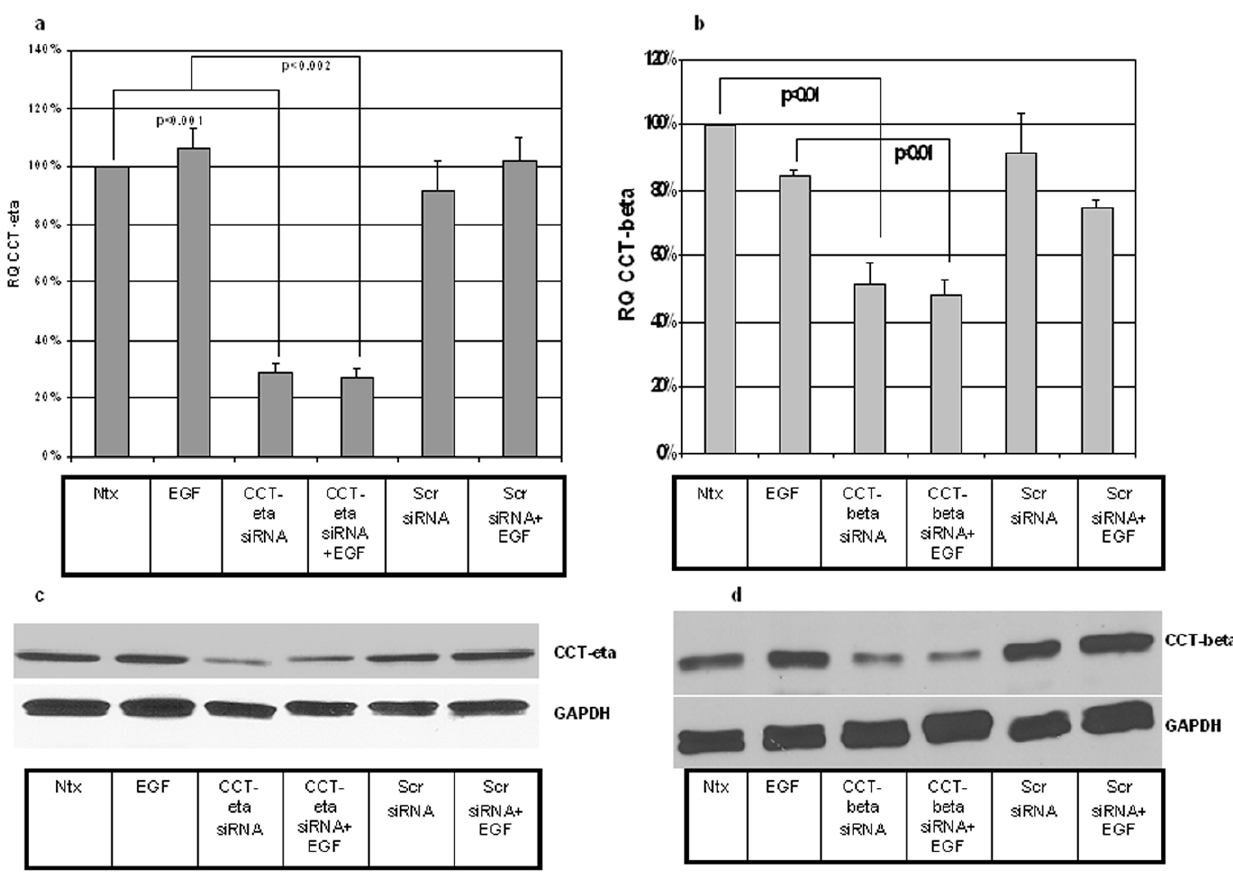
Figure 3. siRNAs against CCT-eta and CCT-beta decrease both basal and EGF- induced mRNA and protein levels of their targets in fibroblasts. (a & b) qRT-PCR analysis of CCT-eta and CCT-beta mRNA levels showed effective inhibition of both basal expression and EGF-induction in siRNA-transfected adult fibroblasts. Results are expressed as relative quotient (RQ) of measured CCT-eta or CCT-beta mRNA and were calculated as a percentage of baseline control levels (100%). Values are means 6 SEM of six independent studies, each performed in duplicate. Statistical analyses were performed with Student’s t test. Ntx- no transfection; EGF-EGF treatment (1 nM); siRNA-treatment with CCT-eta/CCT-beta siRNA; Scr- treatment with scrambled control siRNA. (c & d) Western blot results using CCT-eta and CCT-beta antibody (1:500) showed effective reduction of CCT-eta and CCT-beta protein levels when siRNA was administered but no decrease when scrambled siRNA was employed. GAPDH was used as a loading control. A representative immunoblot of up to four similar such blots is shown for each